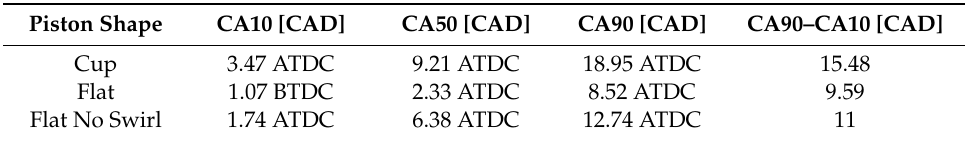
Figure 18. Percentage of total heat release for the three cases. The value on the x-axis identified by the arrows represents the combustion duration.